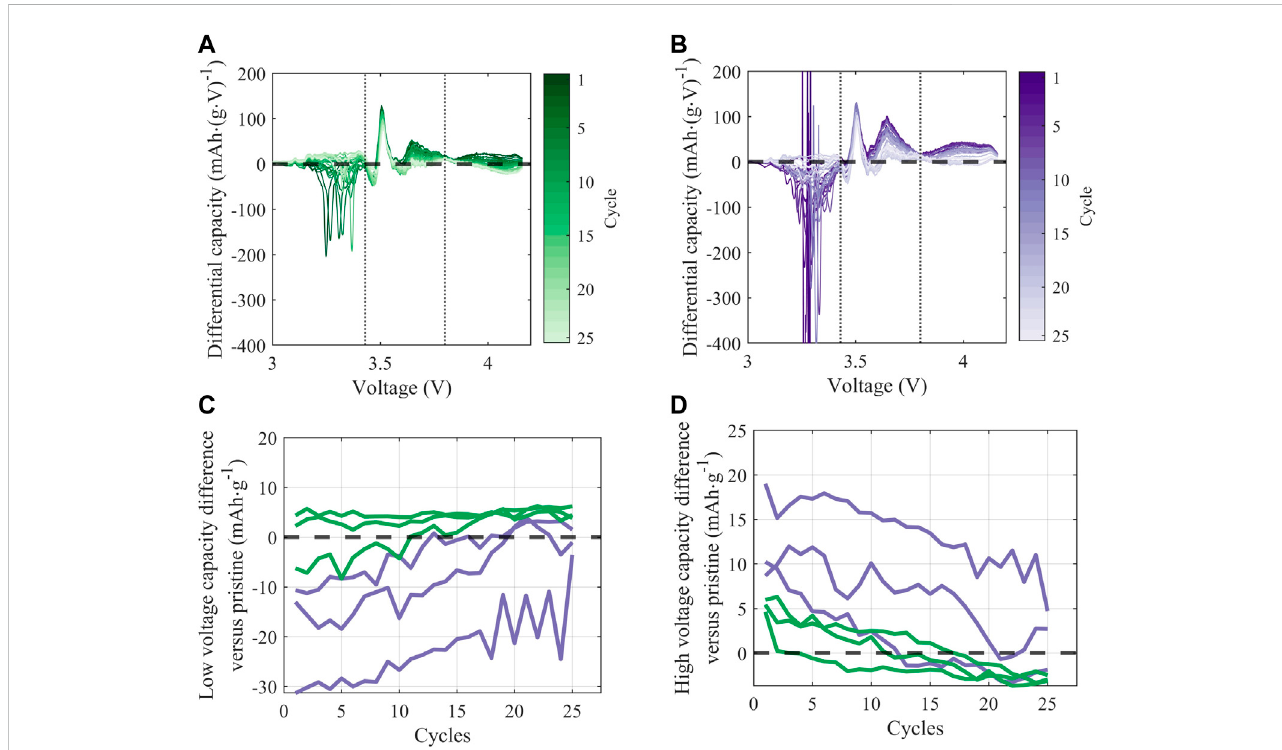
FIGURE 8 (A,B) Differential discharge capacity over 25 C/10 cycles (following formation) for a representative cell treated with (A) KOH and (B) KOH/KCl; vertical dashed lines at 3.43 V and 3.8 V denote the low, middle, and high voltage regions. Normalized dQ/dV is reported as the value from the treated cell minus the fi rst-cycle value from a representative pristine cell (C,D) Capacity from side reactions in (C) low-voltage (3 – 3.43 V) and (D) high-voltage (3.8 – 4.2 V) regions, calculated as the integrated signal area. Lines of the same color re fl ect cell replicates of the same treatment condition (KOH, green; KOH/KCl,